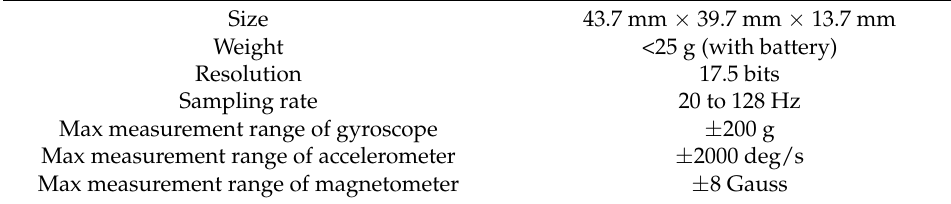
Figure 2. Two IMUs for gait detection. Table 1. Specifications of the APDM OPAL IMU [30].